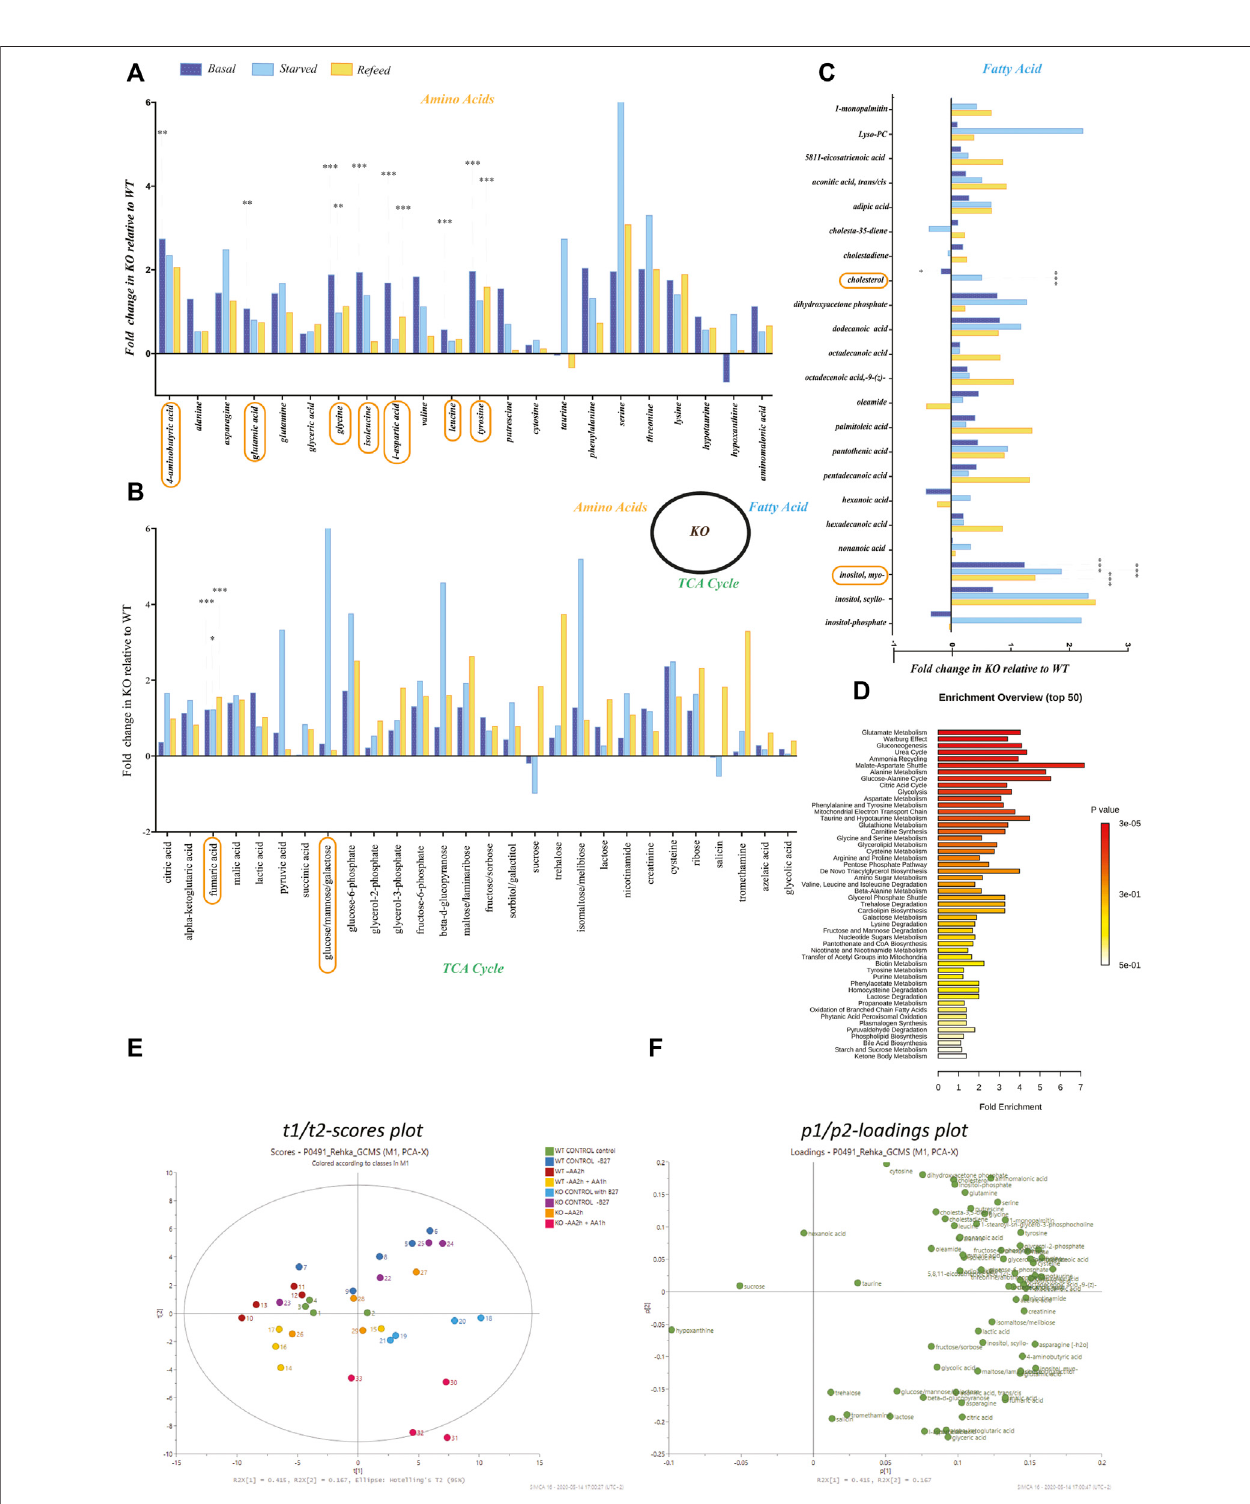
FIGURE 3 | Metabolomics pro fi ling of amino acids, fatty acids, and TCA/glycolysis intermediates in KO primary cortex cells. Metabolomics was performed on WT and KO PCCs using GCMS-MS. (A – C) Fold change of amino acids in KO compared to WT primary cortical neurons for (A) amino acids, (B) TCA cycle metabolites, and (C) metabolites involved in the fatty acid synthesis. Statistical analyses were performed, and signi fi cantly changed molecules were marked after performing a two-way ANOVA and Bonferroni post-tests (* p < 0.05, ** p < 0.01, *** p < 0.001). (D) Metaboanylate pathway enrichment of detected metabolites betweenKOandWTPCCs.Here,weonlyshowmetabolitepathwayswithatleastthreemetabolitesintheset. (E,F) PCAplotsbasedonthemetabolomicspro fi leof KO and WT PCCs. (E) Two dimensional t1/t2-scores plot and (F) loadings plot.